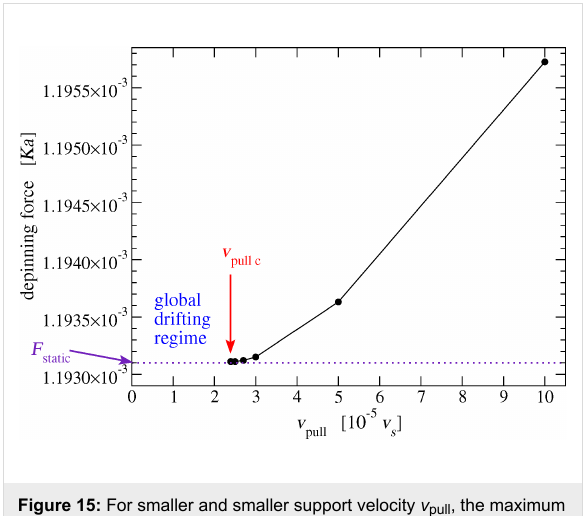
Figure 15: For smaller and smaller support velocity v pull , the maximum elastic force experienced by the slider just before it overtakes one atom of the chain provides a better and better estimation of the static friction F static . By moving closer and closer to the minimum v pull c , we obtain a quantitative estimate of the actual F static , see Equation 16. In these simulations, the pulling elastic constant K pull = 10 − 3 K